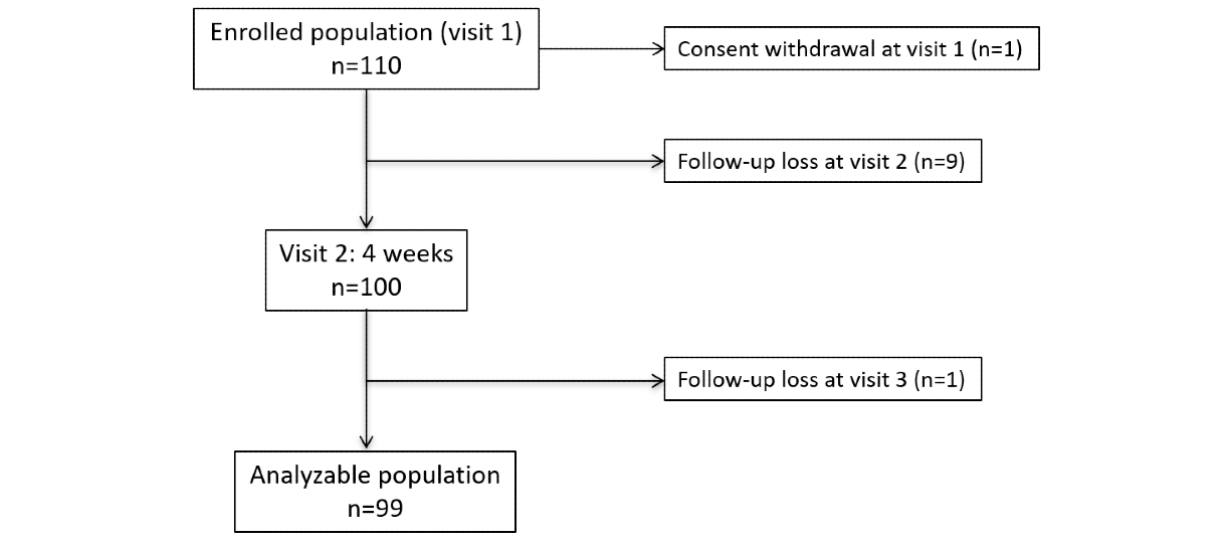
Figure 4. Study flow